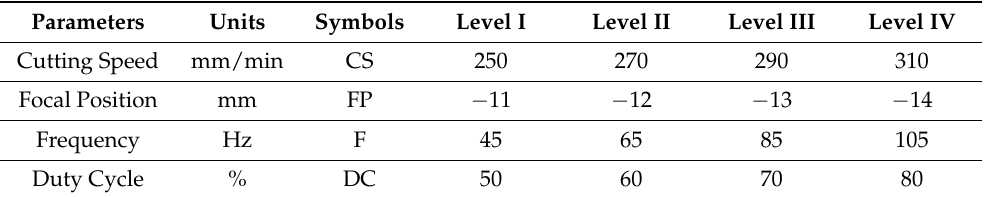
Table 2. Fiber laser-cutting-process parameters and their levels.